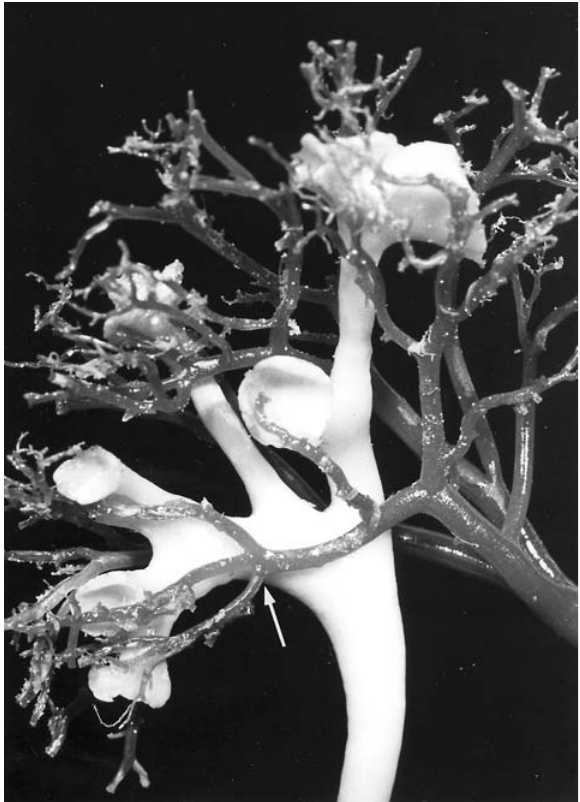
Figure 1 – Posterior view of an endocast (intra-renal arteries and collecting system) demonstrating the posterior branch of the lower pole originating from the posterior division of the renal and coursing in close relationship with the posterior aspect of the lower infundibulum (arrow). From: Sampaio F, Aragão AH: Anatomical relationship between the intrarenal arteries and the kidney collecting system. J Urol. 1990; 143: